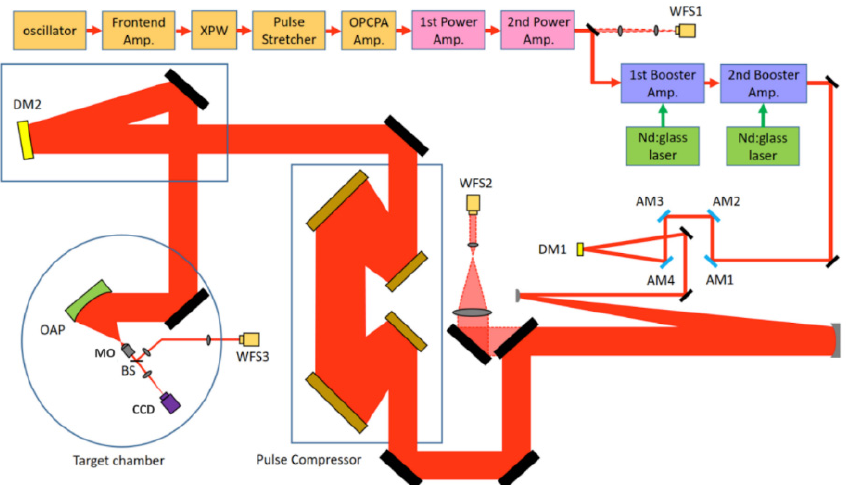
Figure 7. Diagram of the petawatt laser setup with two adaptive systems: WFS1, WFS2, WFS3—wavefront sensors, DM1, DM2—deformable mirrors, AM1–AM4—attenuating mirrors, OAP—off-axis parabolic mirror, MO—micro objective, BS- beam splitter, CCD—video camera.